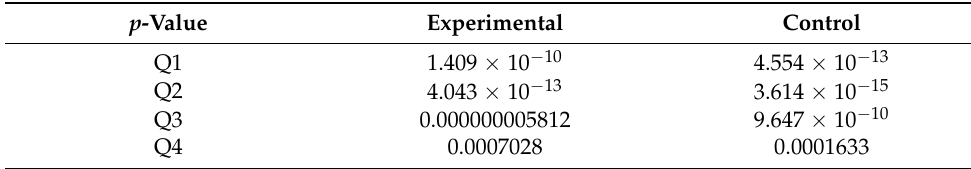
Table 1. Shapiro–Wilk test for experimental and control